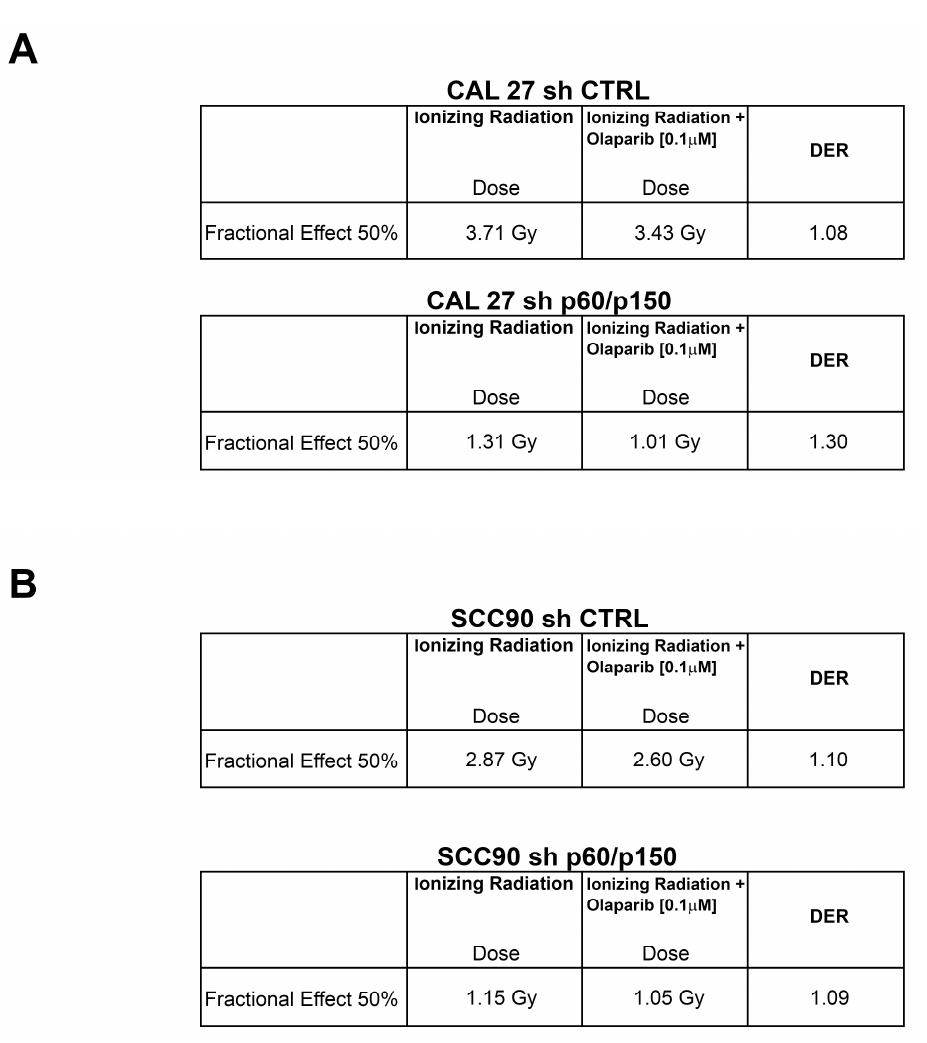
Figure 6. ( A , B ) The Dose Enhancement Ratio (DER) at 50% of the effect refers to the ratio between the dose with radiation alone and the dose with radiation + drug for the same biological effect. If the DER is greater than one, then the addition of the drug is functioning as a radiosensitizer. If the DER is less than one, the drug acts as a radioprotector. In the table are shown DER values at 50% effect for CAL 27 (sh CTRL vs. sh p60/p150) and SCC90 (sh CTRL vs. sh p60/p150).